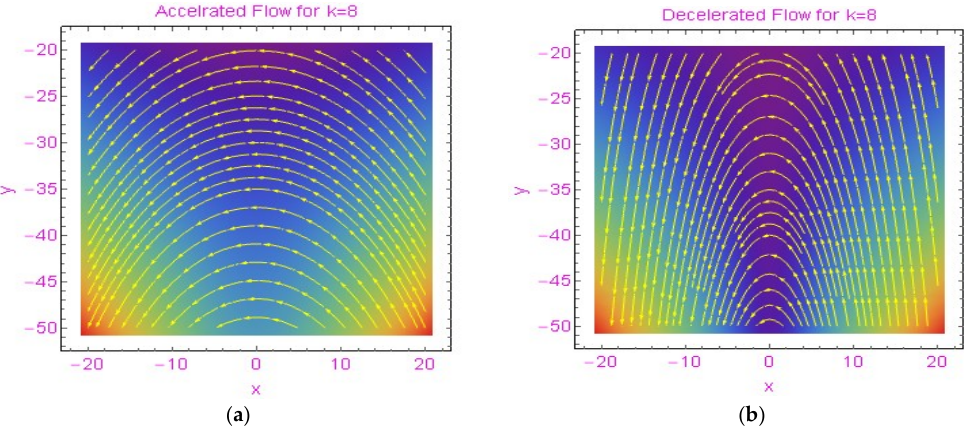
Figure 5. Streamlines behavior for ( a ) accelerated and ( b ) decelerated flow situations when k = 8. Figure 6 elucidates the impact of suction of nanofluid for accelerated and decelerated flow